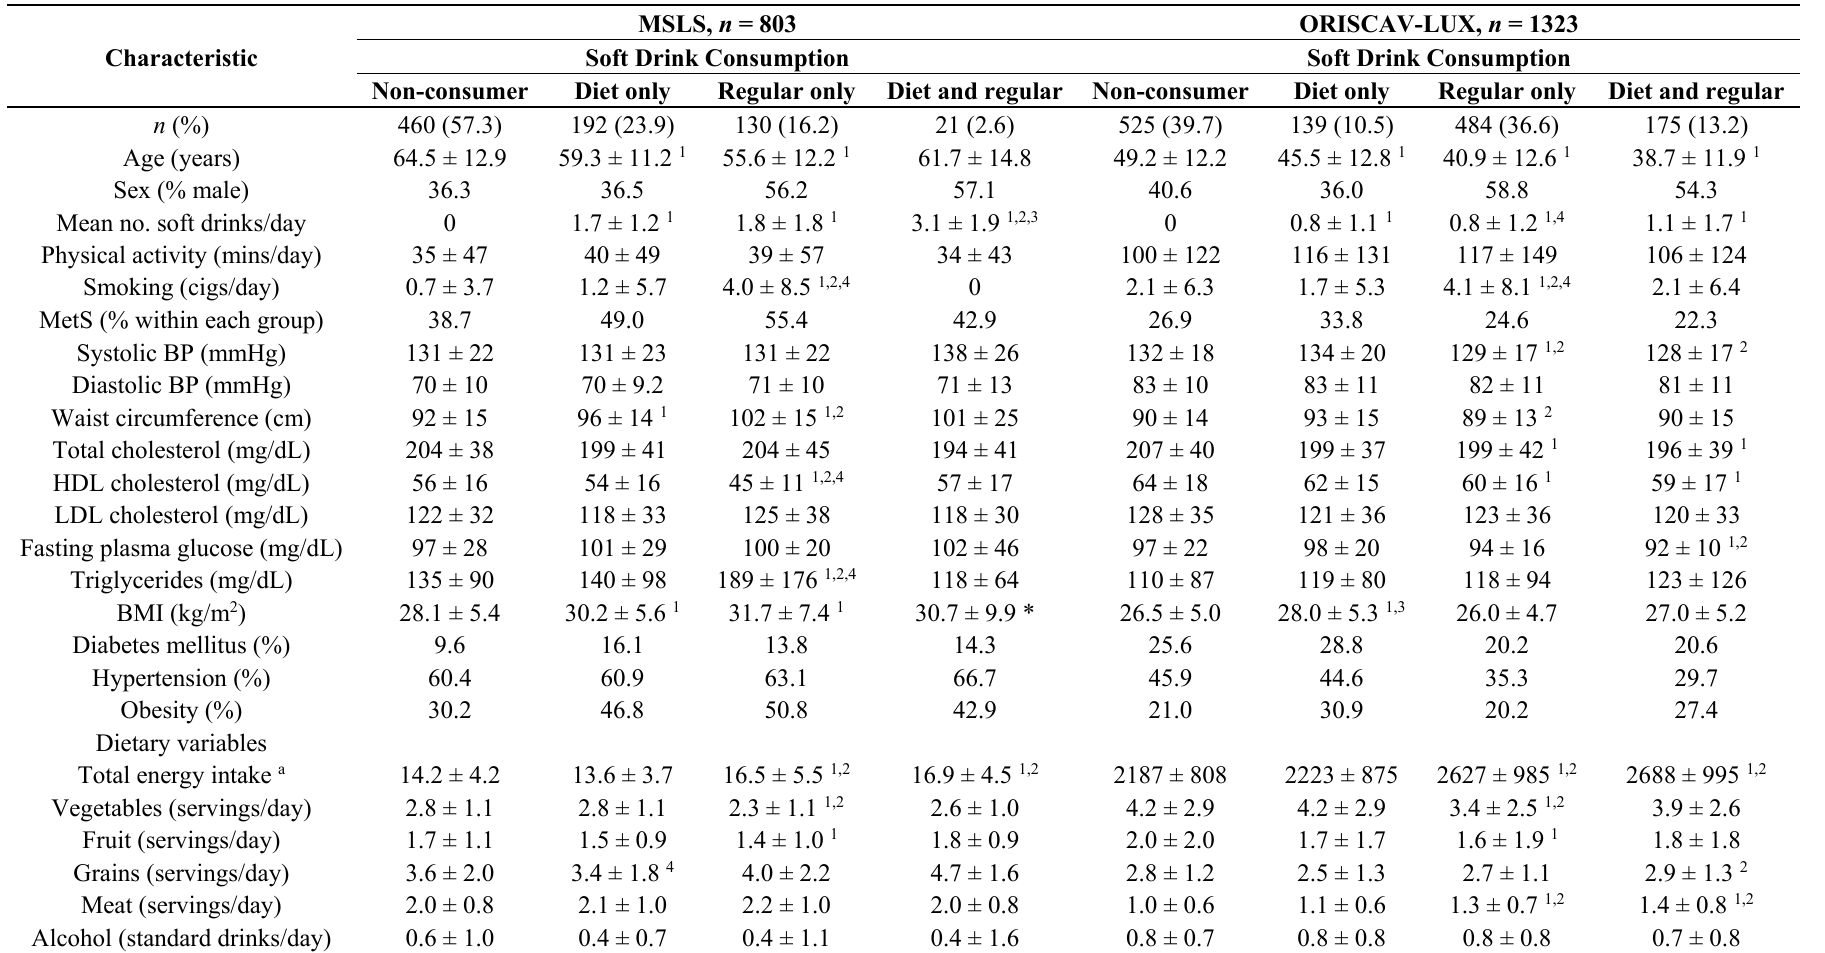
Table 1. Study sample characteristics according to daily soft drink consumption in ORISCAV-LUX and MSLS studies.